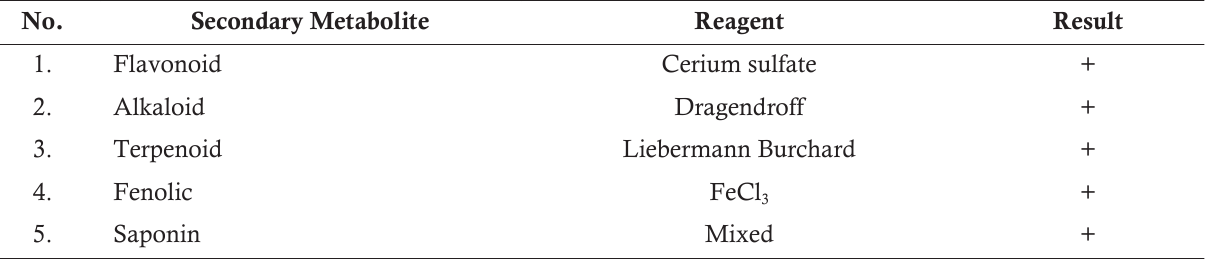
Table 1. Result of phytochemical Analysis